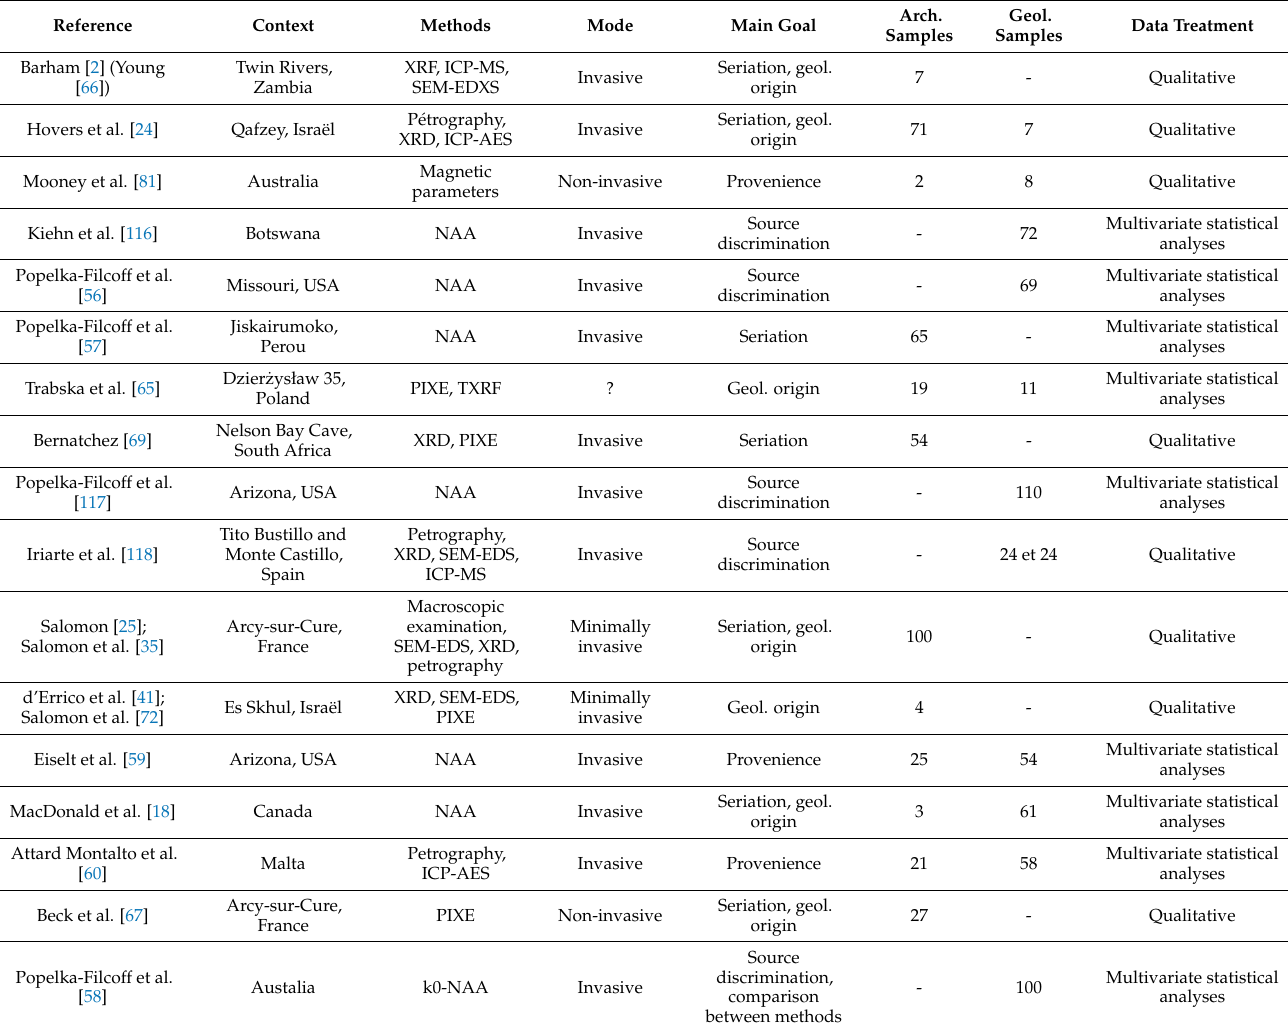
Table 2. Short description of the various methodologies developed in ochre provenance researches in the last two decades. Reference Context Methods Mode